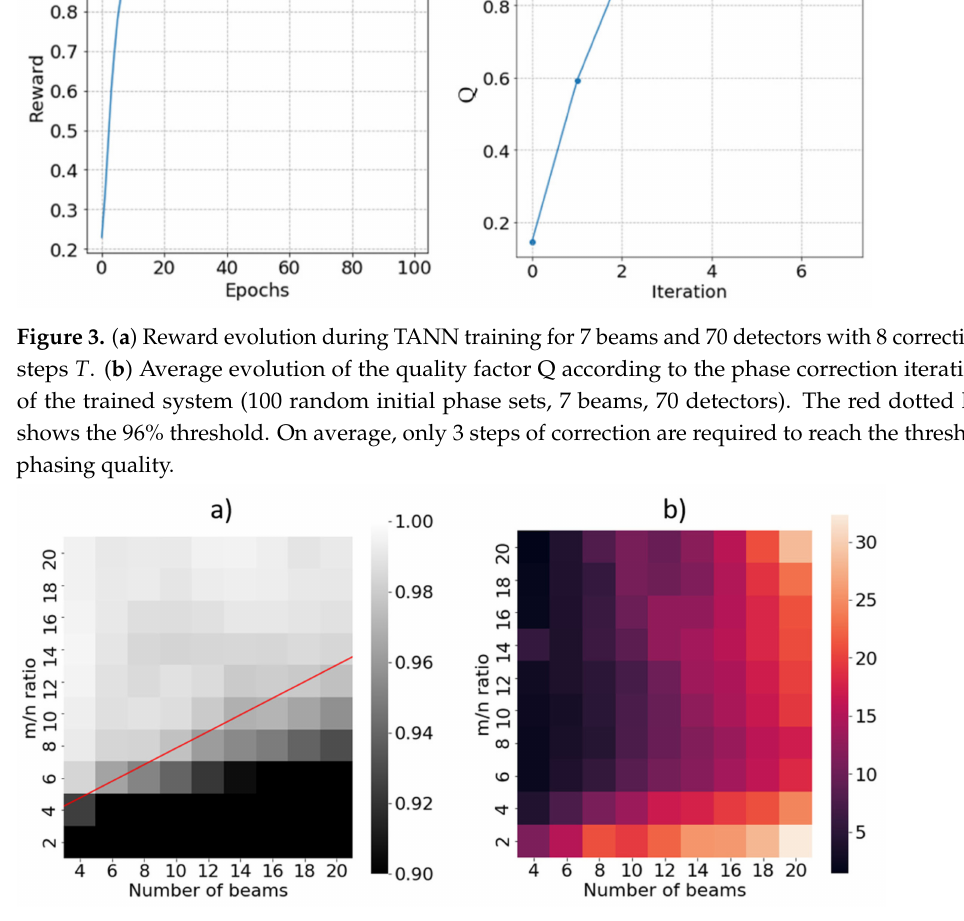
Figure 4. ( a ) Heat maps of the maximal achievable mean reward in grey scale and ( b ) its required relative training time. The red line in ( a ) approximates the separation line for which r = 0.96. The relative time on ( b ) is computed by dividing a learning time in seconds for each n and m / n by the minimal time to obtain GPU invariant information. The minimal time required by the GPU used in this paper was 13